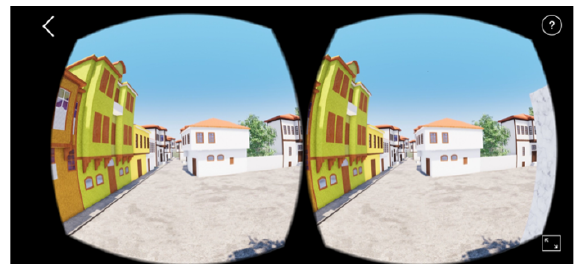
Figure 6. 3D visualization by using VR mobile